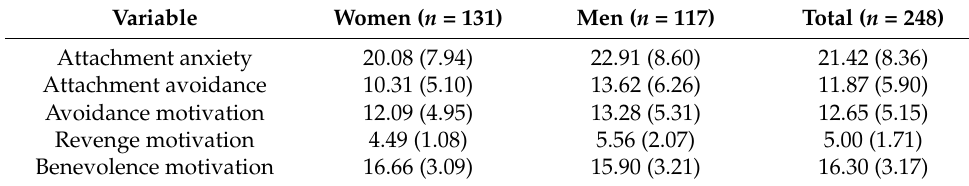
Table 2. Descriptive statistics of the study